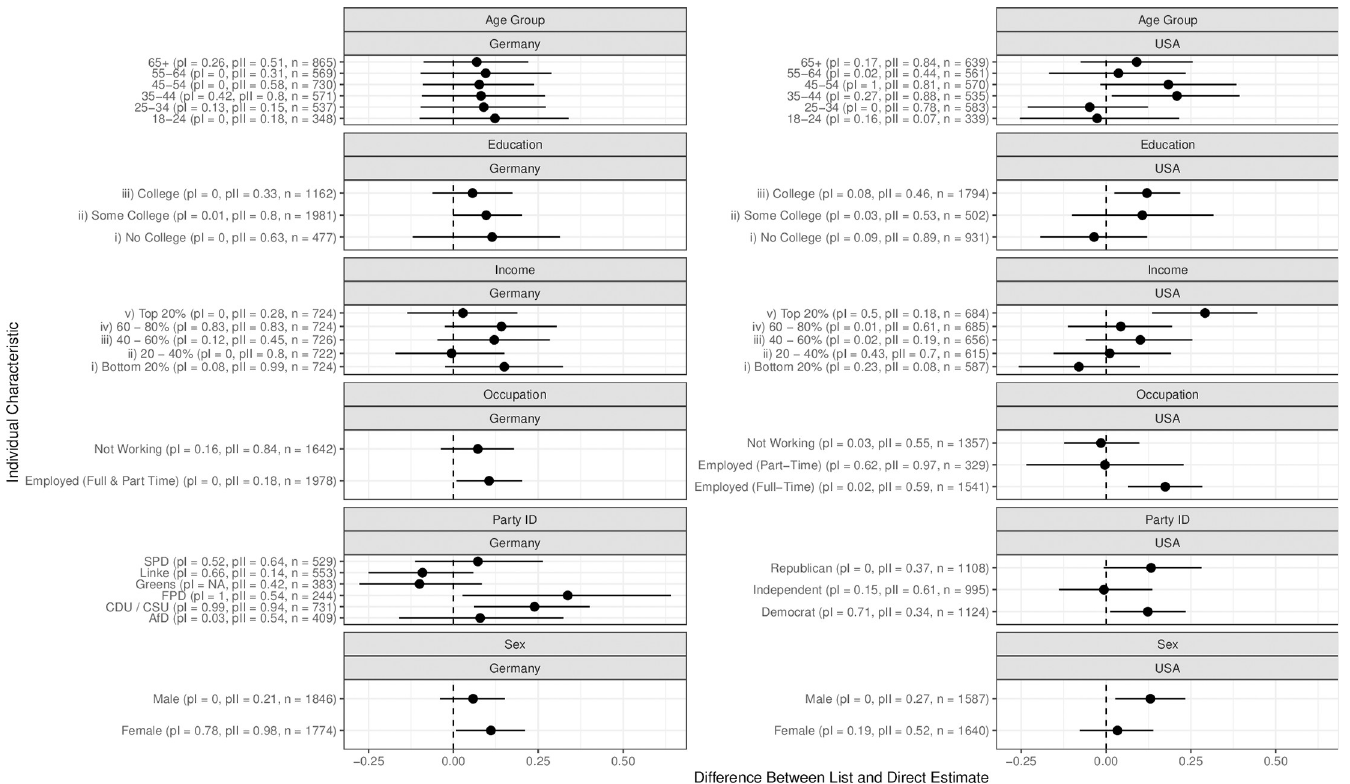
Fig 3. Misreporting of climate change skepticism according to individuals’ characteristics. Each point indicates the estimated difference between the list experiment and direct question estimate, presented in Fig 2. 95% confidence are calculated using 1000 bootstrap samples.